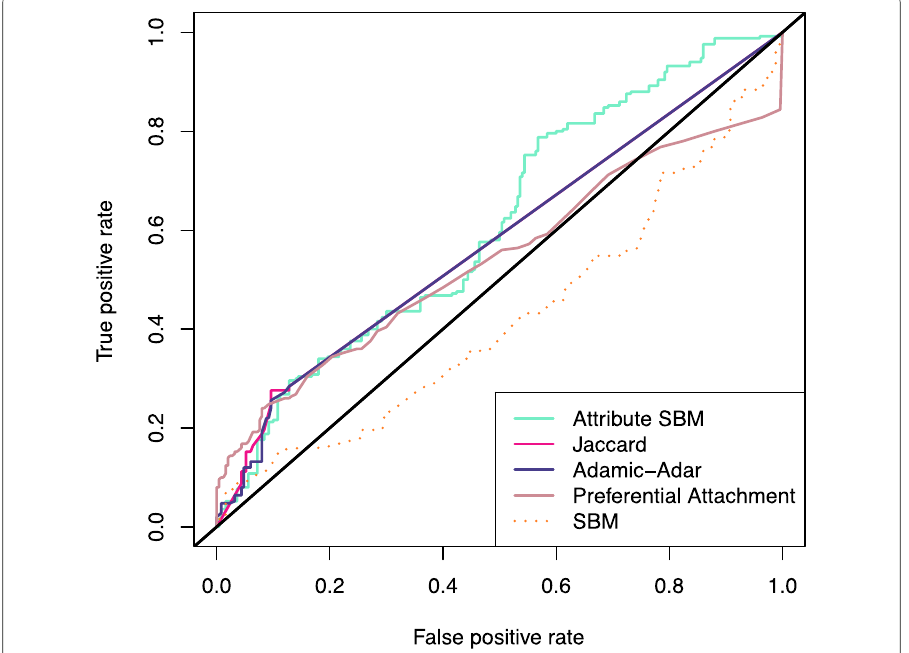
Fig. 5 Link Prediction in the protein interaction network. Performing link prediction using the attributed SBM, Jaccard, Adamic Adar, preferential attachment, and SBM. The corresponding AUC curves for these methods were 0.61, 0.58, 0.58, 0.54, and 0.42,